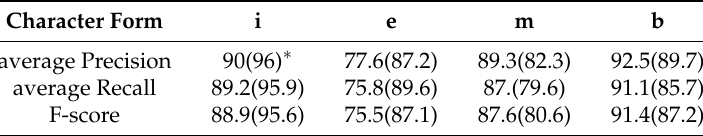
Table 3. Quality of writer independent SVM classification, ∗ values in () are weighted according class